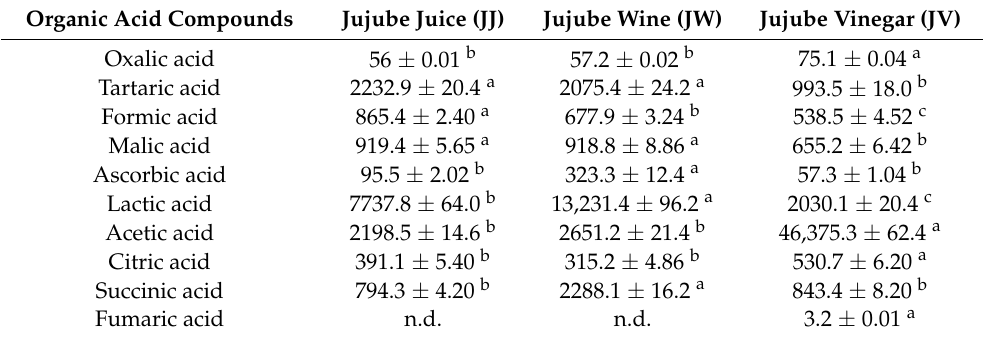
Table 3. Organic acid contents (ppm) of jujube juice (JJ), jujube wine (JW) and jujube vinegar (JV). Organic Acid Compounds Jujube Juice (JJ) Jujube Wine (JW) Oxalic